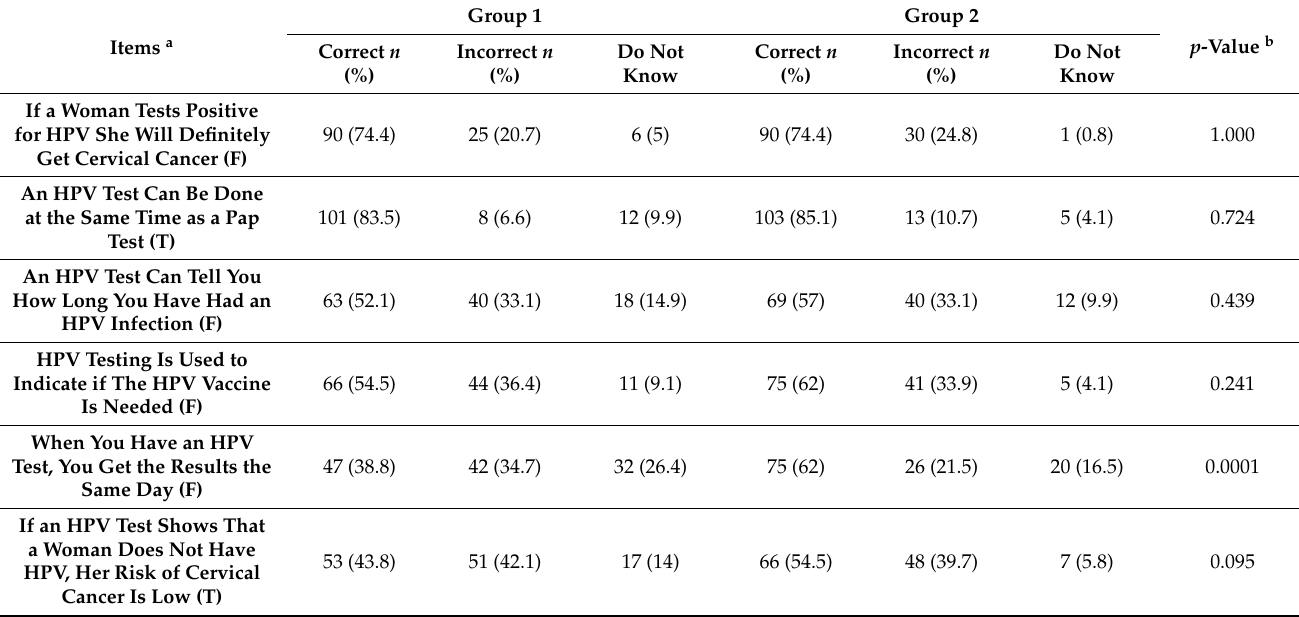
Table 4. Comparison of HPV testing knowledge after receiving the intervention between the two groups.